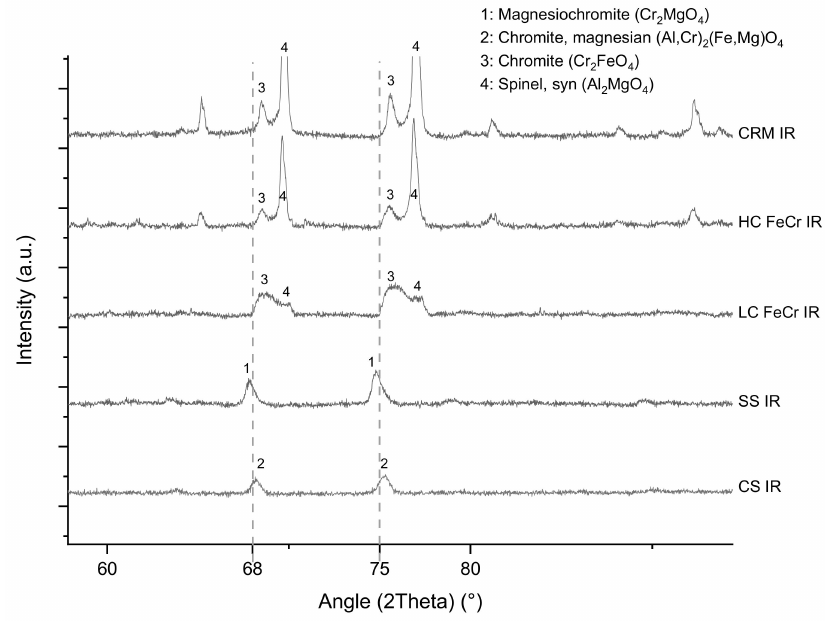
Figure 9. XRD analysis of insoluble residues after HCl / HNO 3 / HBF 4